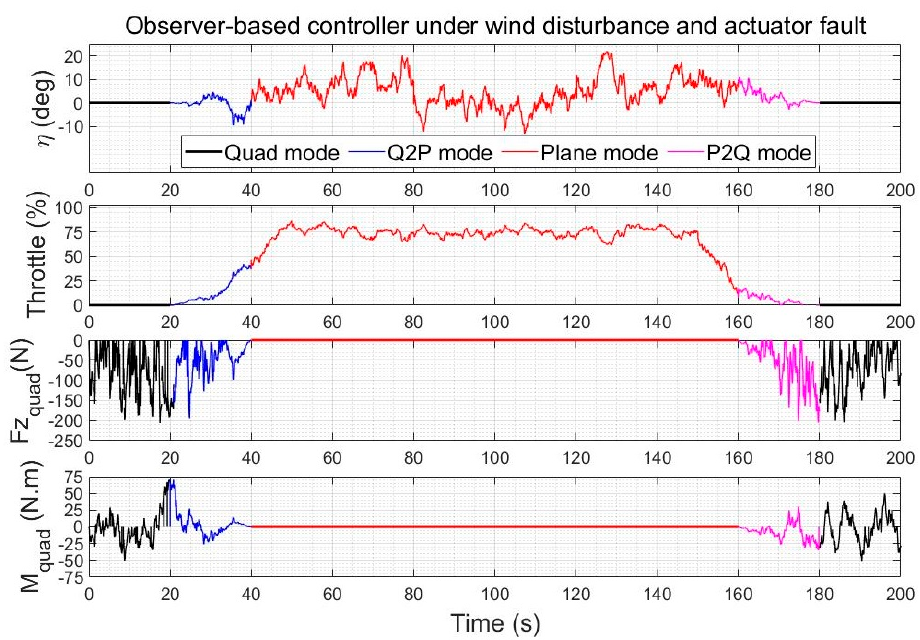
Figure 19. Quadplane control inputs using the observer − based controller during a climb − cruise − land manoeuvre under winds and an elevator fault between 80 s and 120 s.